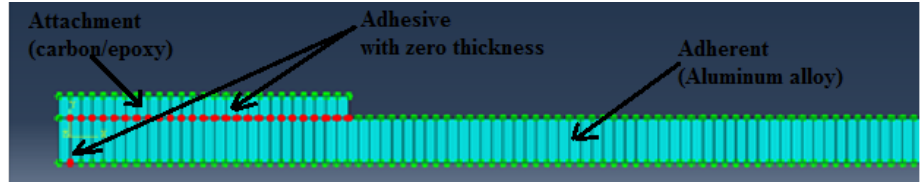
Figure 13. Meshed specimen with zero thickness of cohesive elements.